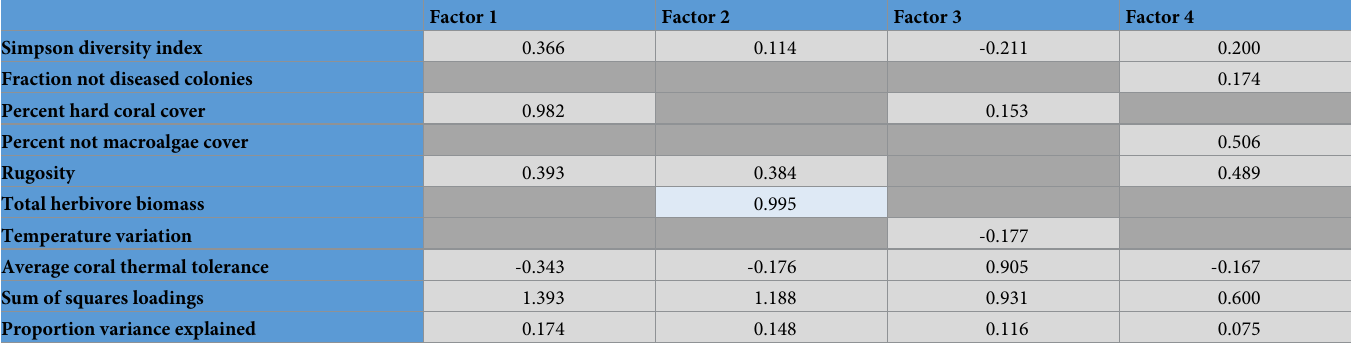
Table 4. Loadings from an exploratory factor analysis using varimax rotation. Four factors had eigenvalues > 1 and were therefore extracted. Blank cells had loadings <